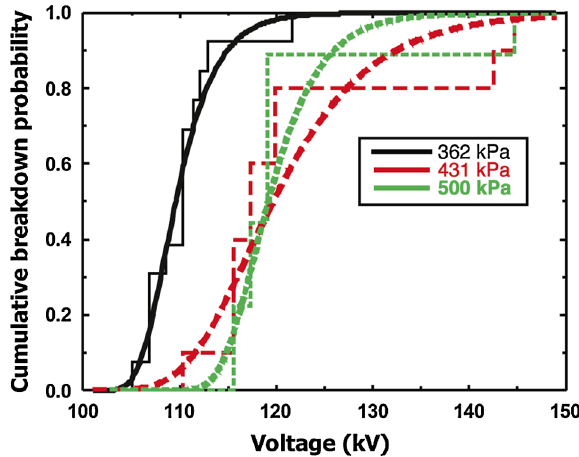
FIG. 4. (Color) Cumulative breakdown probability plot for 362, 431, and 500 kPa SF6 pressure, generated from a largest extreme value model fit to the self-breakdown voltage data at three pressures, shown with self-break data (stairstepped). Data are taken with 4 mm electrode gap, and shown scaled linearly to the operational gap of 7 mm. The calculated prefire probability at 431 kPa and 100 kV is less than 10 (cid:1) 5